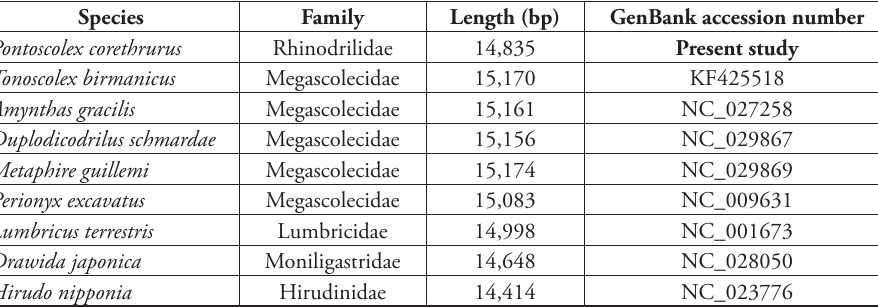
Table 2. Representative Clitellata species included in this study for